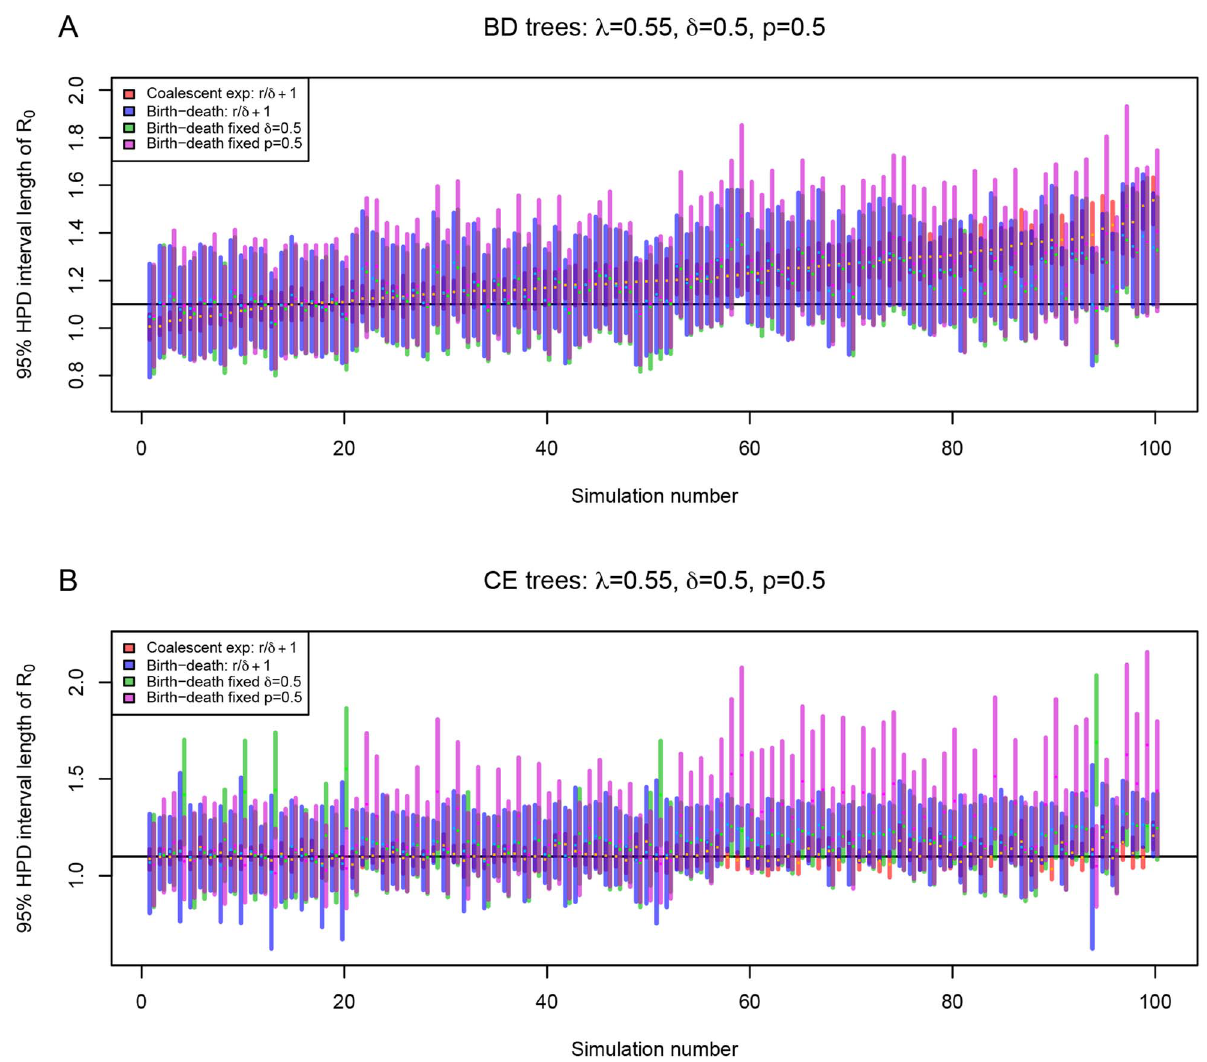
Figure 5. Effect of different information used in the R 0 parameter inference. For setting l ~ 0 : 55, d ~ 0 : 5 and p ~ 0 : 5 ( R 0 ~ 1 : 1 ), we estimated the R 0 parameter from the birth-death trees (A) and the coalescent trees (B) using four methods. First, using the coalescent posterior estimates of the growth rate r and the true d , we obtained R 0 ~ r = d z 1 ~ ( l { d ) = d z 1 ~ l = d (red bars). Second, we used the birth-death posterior estimates of r (trees analysed under uniform priors for R 0 , d , and p ), and the true d in the post-processing (blue bars), similar to the procedure used for the coalescent. Third, we also analyzed the trees by fixing the prior on the death rate d to the true value, d ~ 0 : 5 (green bars) or by fixing the prior on the sampling probability p to the true value, p ~ 0 : 5 (purple bars) during the MCMC analysis. Note that y-axis now displays 95% HPD of the R 0 parameter, and within each figure, the trees (simulations) are ordered (x-axis) by the median estimate of growth rate r parameter estimated by the coalescent on the birth-death trees.